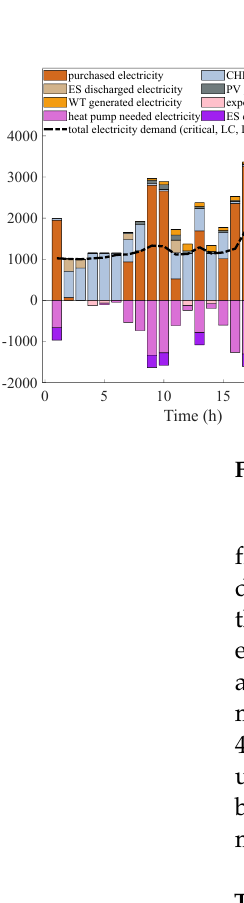
Figure 7. Operational results of microgrid 2.